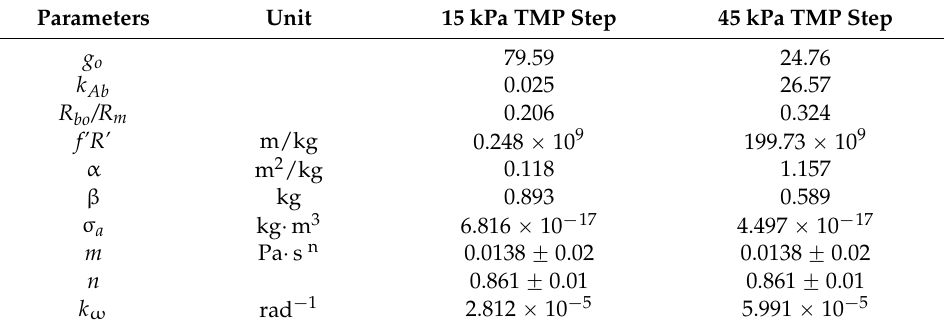
Table 2. Simulations best fit model parameters for rotating MBR system